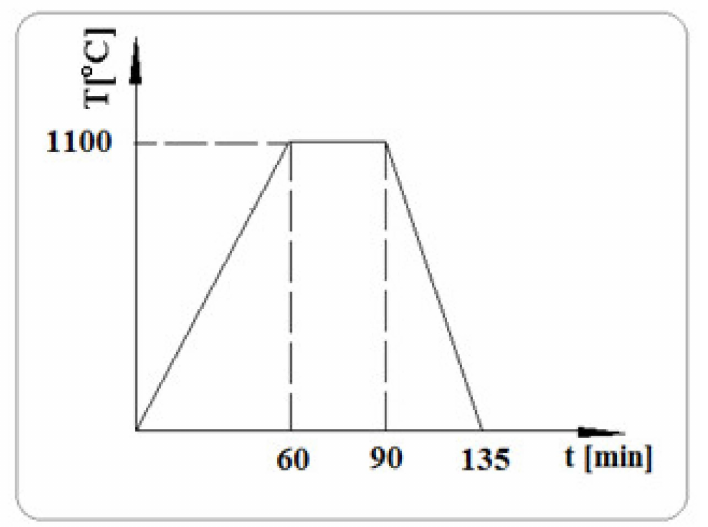
Figure 10. Lighter hardening diagram (T-hardening temperature, [ ◦ C]; t-hardening time,